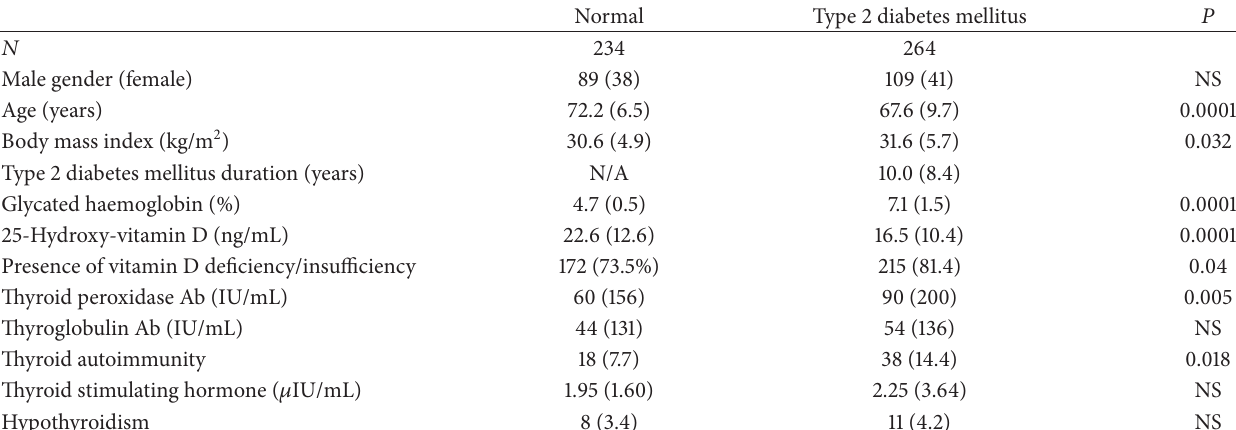
Table 1: Descriptive characteristics of the study population.